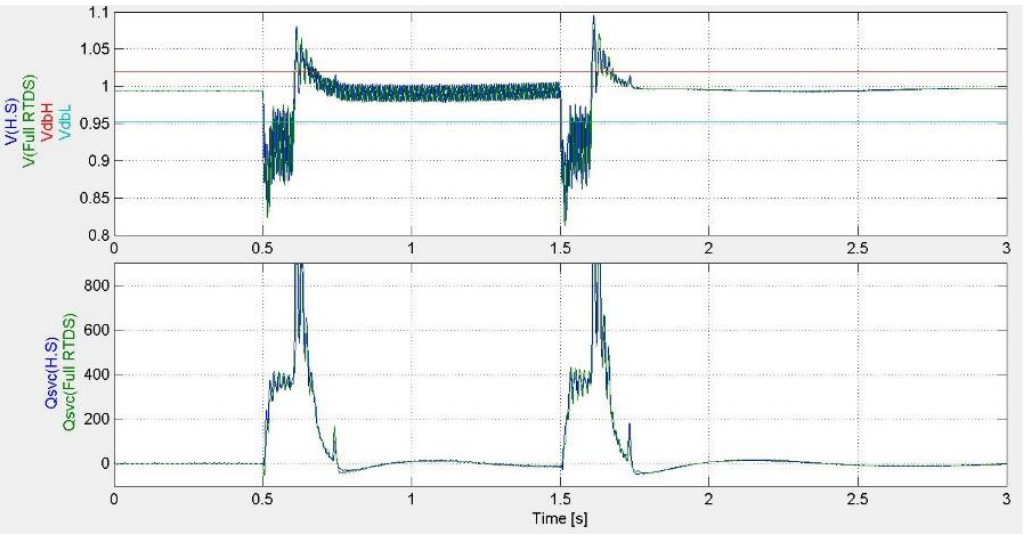
Figure 12. A 765 kV line fault is applied nearby Shin-Jecheon; Shin-Jecheon bus voltage (first row) and reactive power of SVC (second row); RTHS (blue line) and large-scale RTS (green line).